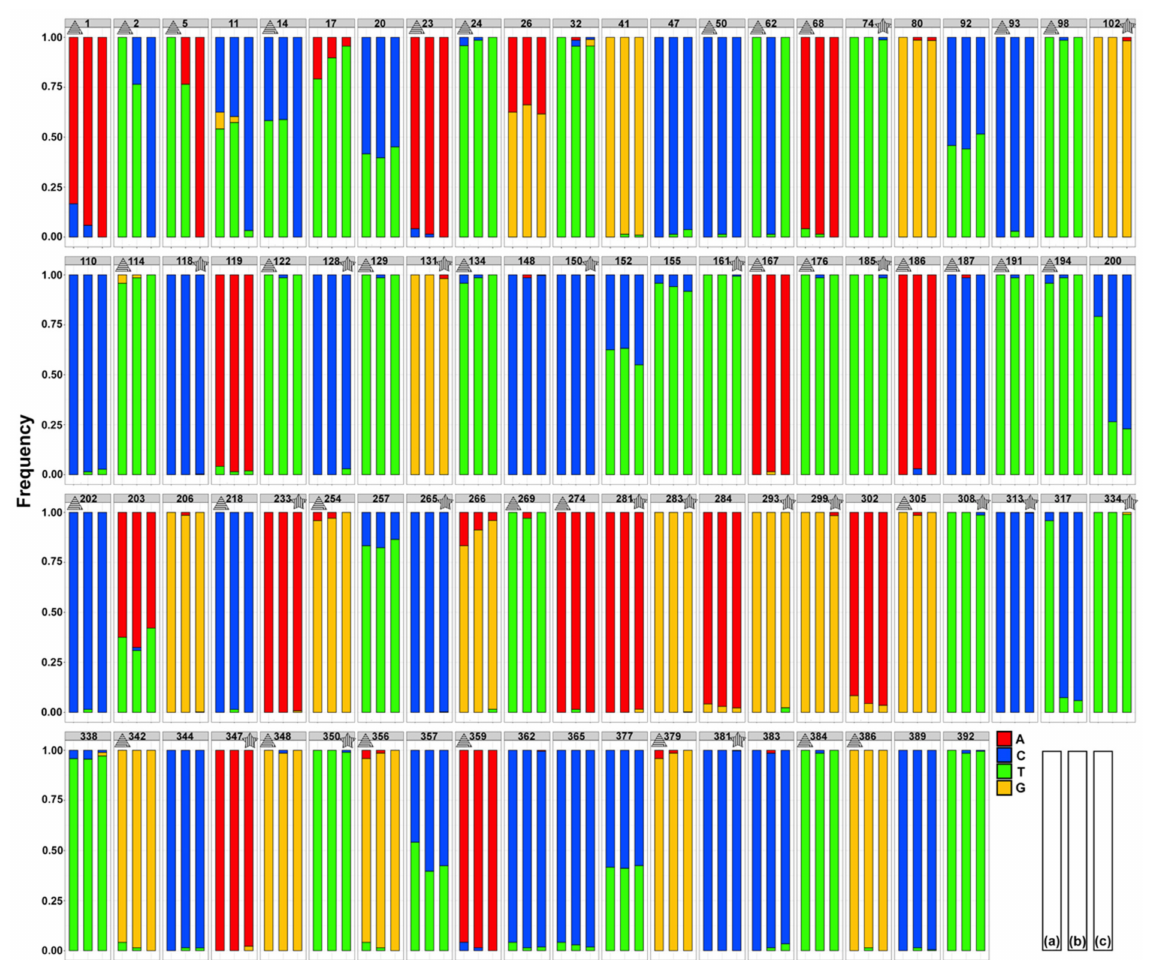
Figure 8. Distribution of allele frequencies across all captured polymorphic sites in the cox 1 gene portion of Cichlido- gyrus casuarinus in ( a ) Individual-based sequences ex Hemibates stenosoma , Mpulungu, September 2018, ( b ) Individual- based sequencing including all sequence data of C. casuarinus available, ( c ) Pooled NGS dataset ex H. stenosoma , Mpu- lungu, September 2018. Polymorphic sites unique to individual-based or NGS datasets are marked with triangle and asterisk,